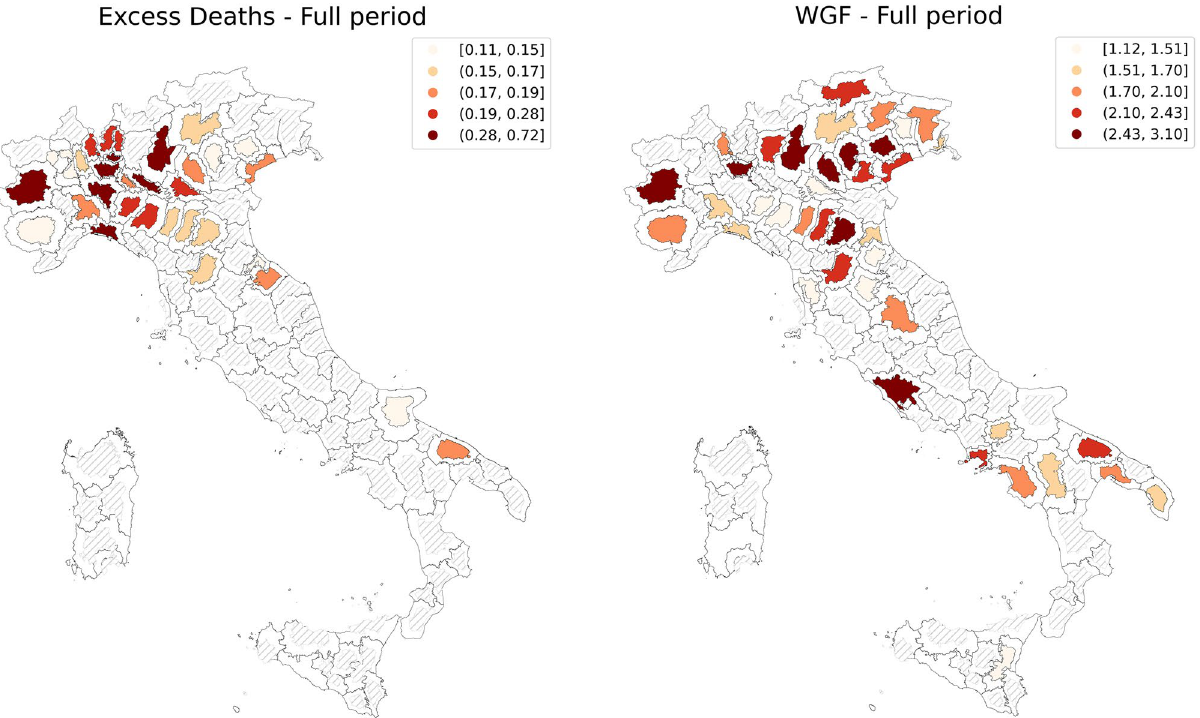
Figure 2. Graphical representation of the NUTS 3 region-specific fixed effects estimated through model (2). The color intensity of NUTS3 regions (Italian provinces) is proportional to the associated fixed-effect coefficient: darker colors denote higher coefficients. Each region in the plot is rescaled according to the average change in mobility that occurred between March and April 2020. The map on the left displays NUTS 3 specific fixed- effects estimates obtained when regressing the logarithm of excess deaths on mobility range (Table 1, column 1); the right-hand picture shows fixed-effects estimates when the Wage Guarantee Fund is the dependent variable (Table 1, column